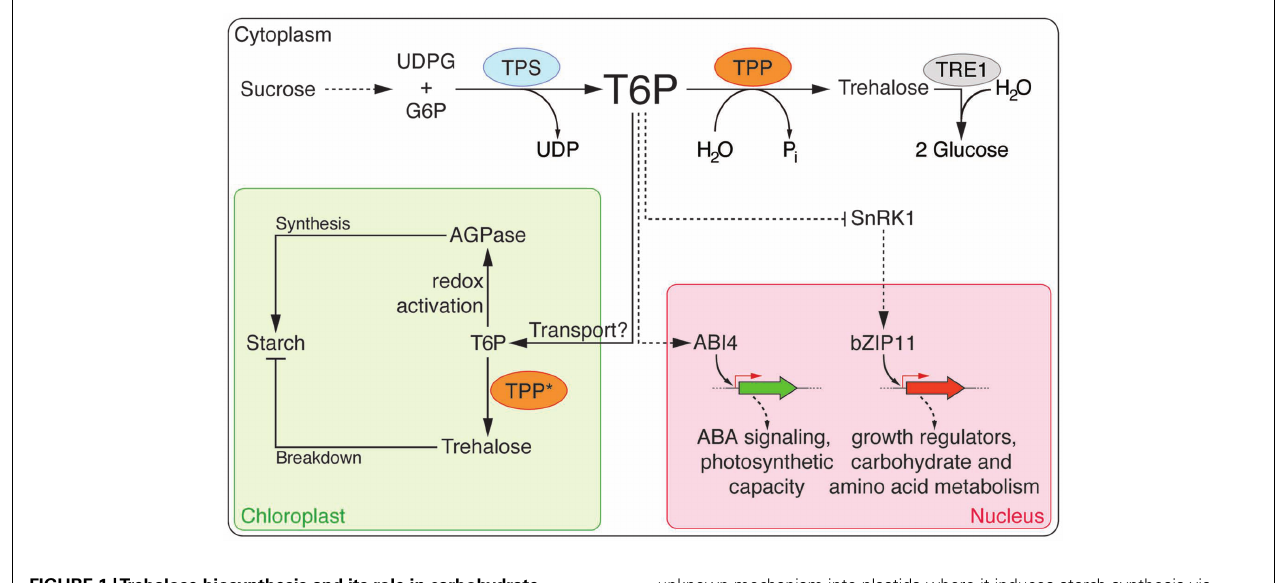
FIGURE 1 |Trehalose biosynthesis and its role in carbohydrate metabolism. Trehalose-6-phosphate (T6P) is synthesized from UDP-glucose (UDPG) and glucose-6-P (G6P) by the activity of trehalose-6-phosphate synthase (TPS) and subsequently converted to trehalose by trehalose-6-phosphate phosphatase (TPP). trehalase1 (TRE1) hydrolyzes trehalose into two molecules of glucose.T6P plays a central role in regulating sugar metabolism in plants.The precursors ofT6P are derived from the sucrose metabolism. It has been suggested thatT6P is transported by an